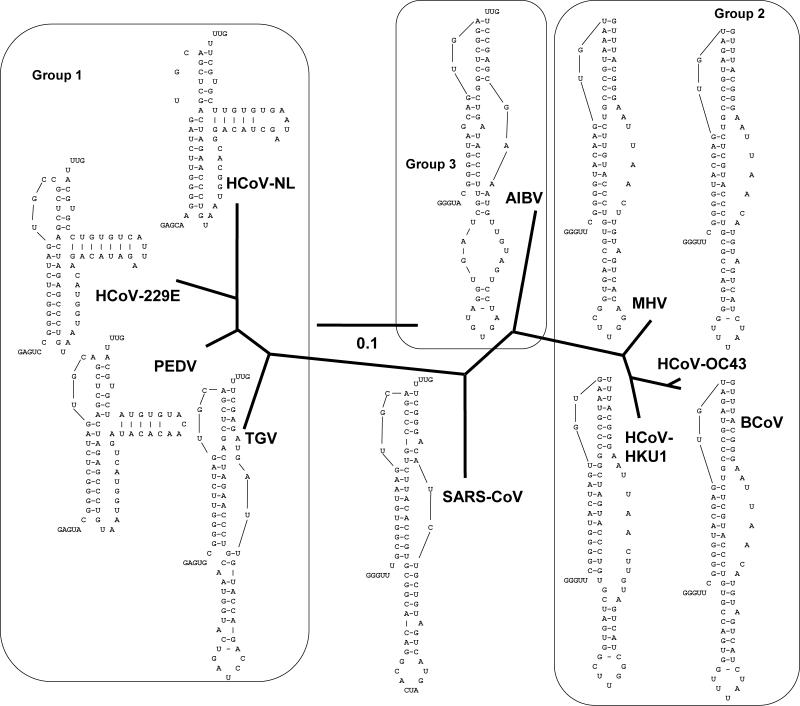
Phylogenetic Analyses of Coronavirus −1 PRF SignalsUnrooted tree constructed based on the multiple sequence alignment from Figure 2.